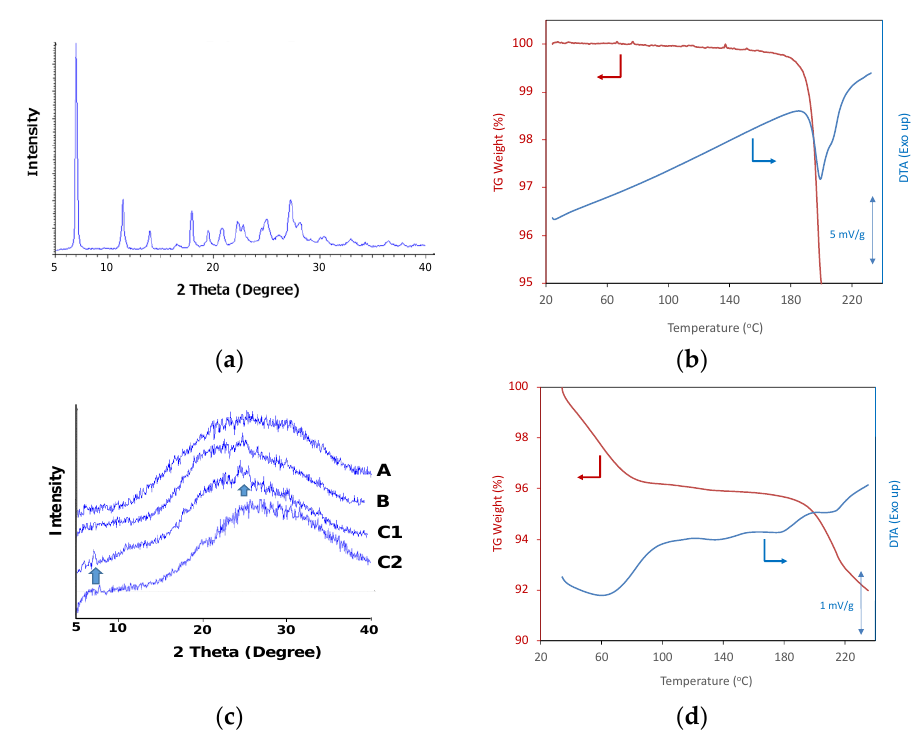
Figure 2. ( a ) PXRD pattern of crystalline ALZ. ( b ) TG-DTA curve of crystalline ALZ. ( c ) PXRD patterns of ALZ ASDs. A: Eudragit/ALZ = 3/1, B: HPMCAS/ALZ = 3/1, C1: PVPVA/ALZ = 3/1, C2: PVPVA/ALZ = 4/1. ( d ) TG-DTA curve of PVPVA/ALZ = 3/1 ASD.